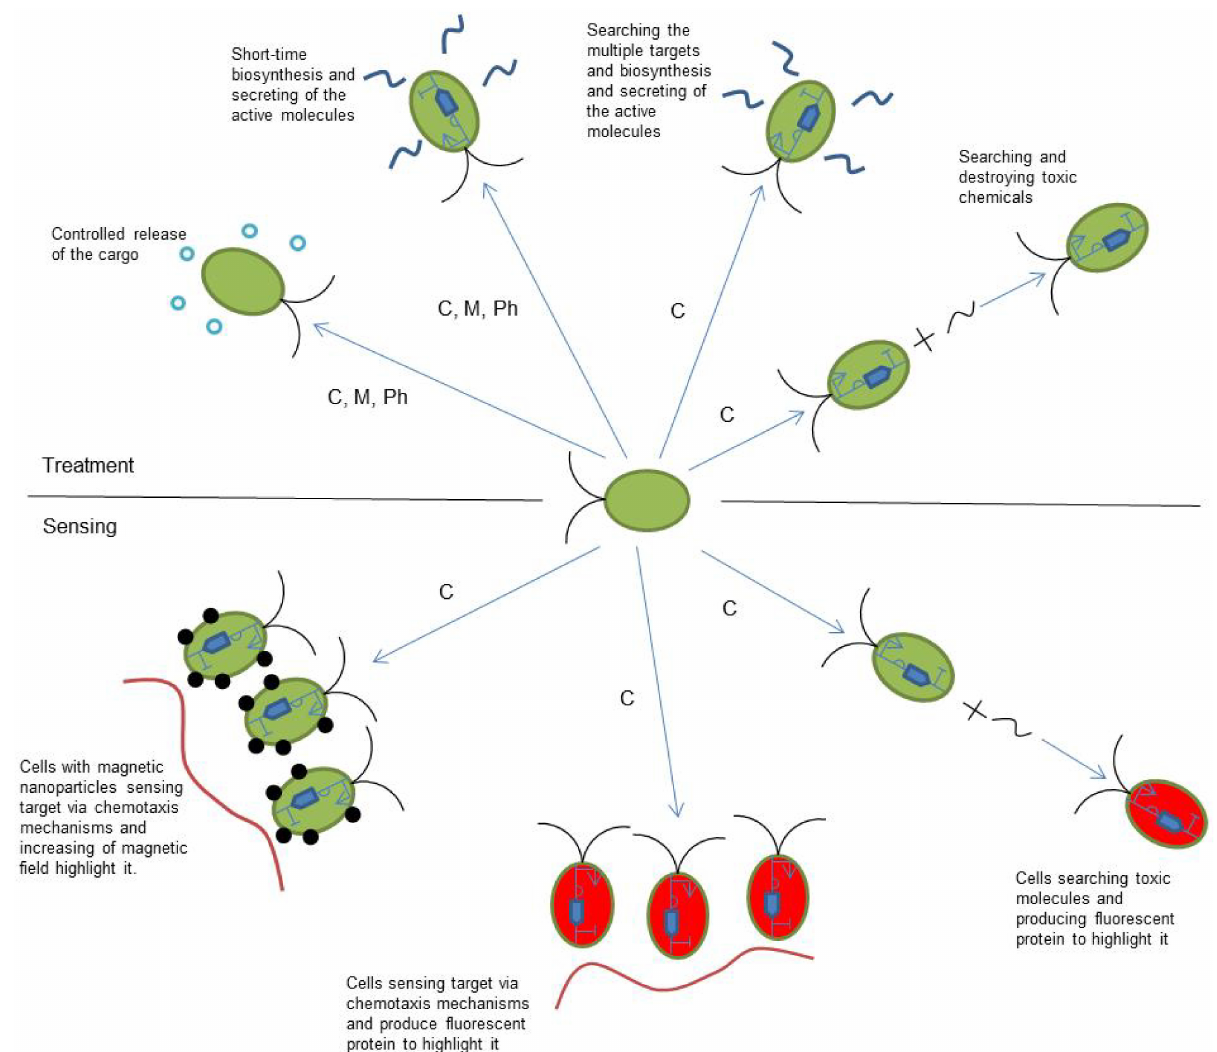
Figure 3. Possible applications of microbial cell-based microrobots for medical treatment and sensing. C, M, and Ph are the motility types that can be used for current applications and are chemotaxis, magnetotaxis, and phototaxis,